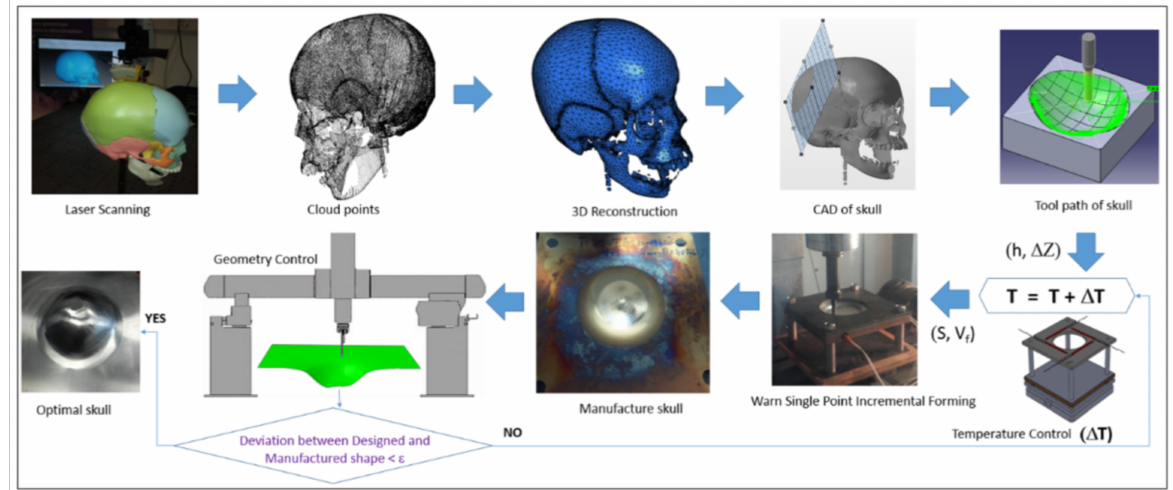
Figure 5. A reverse engineering application to human skull manufacture (reprinted with permission from [79]; copyright © 2018, Springer-Verlag London Ltd., part of Springer